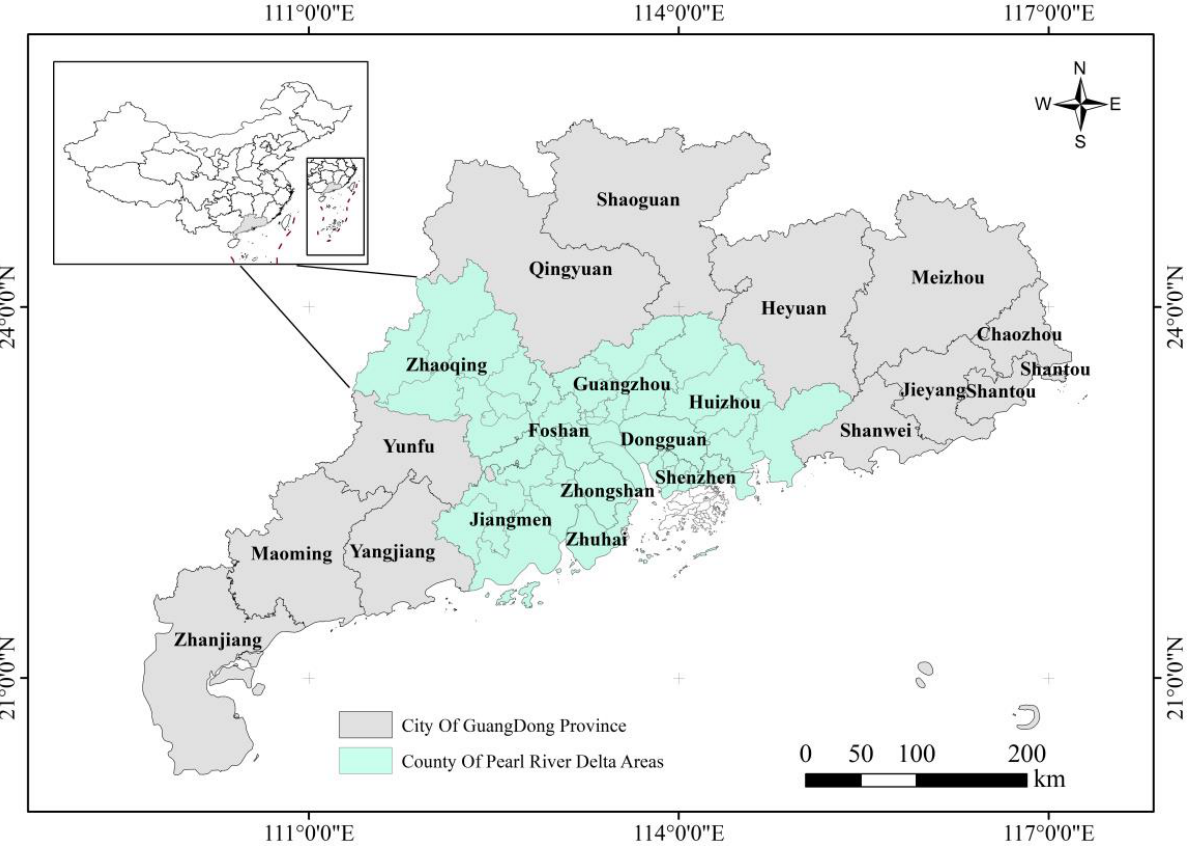
Figure 1. Sketch map of the study area.